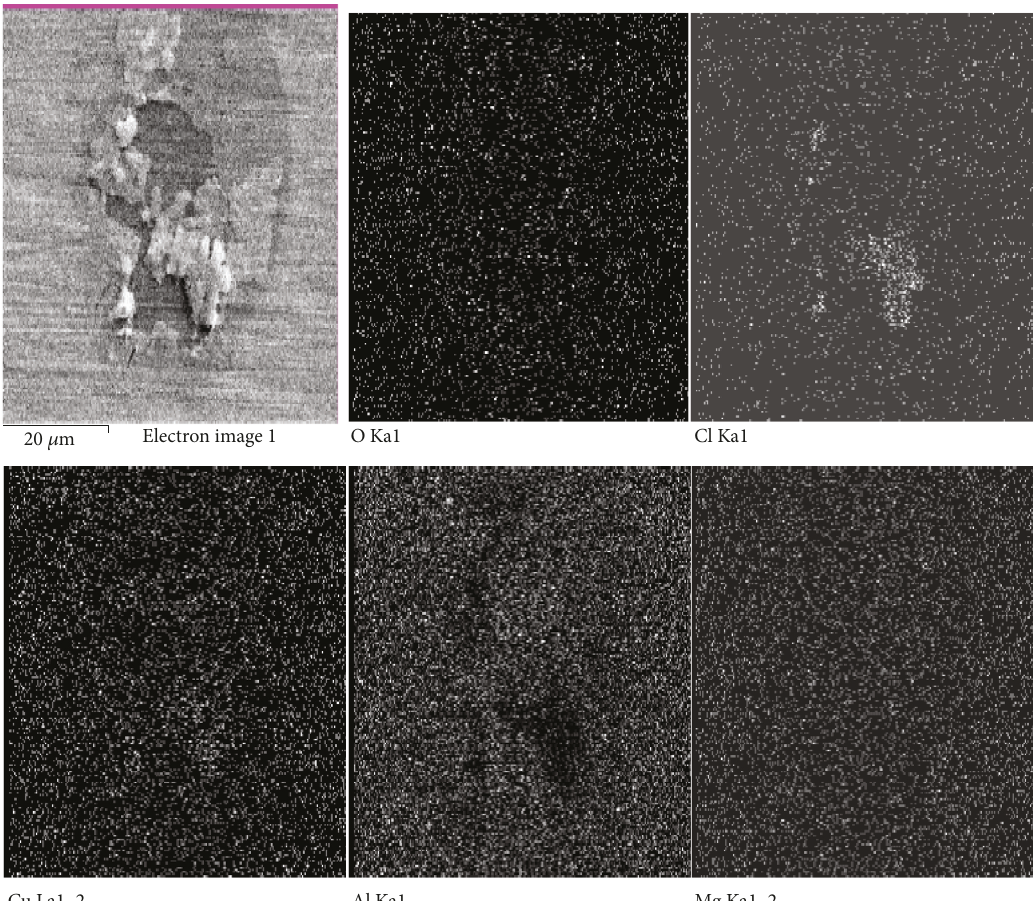
Figure 9: Element distribution map at 1